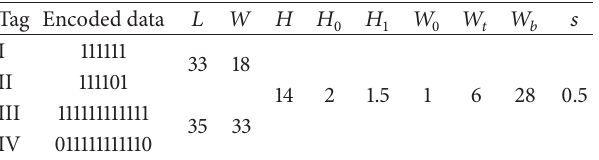
Table 1: Fabricated tag dimension in